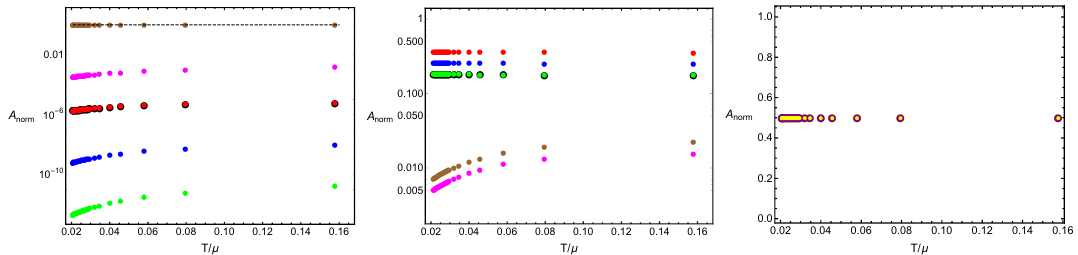
Figure 5 . The amplitudes of the various field theory operators (4.7) in the normal phase ( T > T c ) at fixed k/T = 0 . 01 for the diffusive mode ( left ), first sound ( center ), and the gapped scalar modes ( right ). The color scheme is that illustrated in